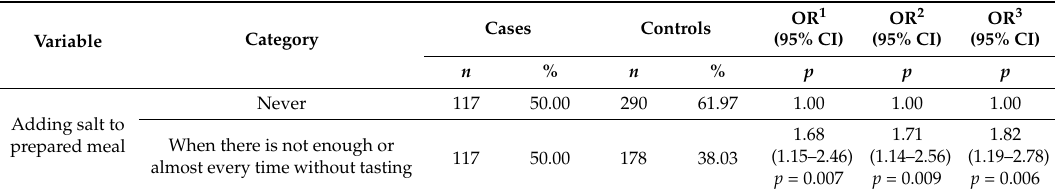
Table 3. The odds ratios and 95% confidence interval for type 2 diabetes mellitus in relation to adding salt to a prepared